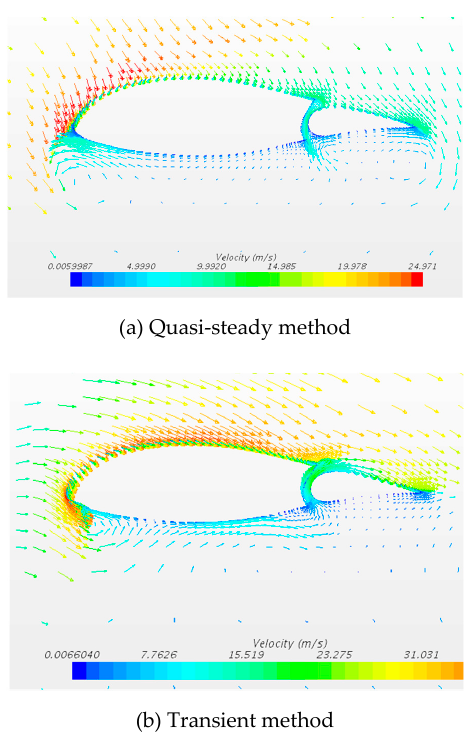
Figure 18. Velocity vector distribution near a wing section simulated by both methods. (a) Quasi-steady method; (b) Transient method